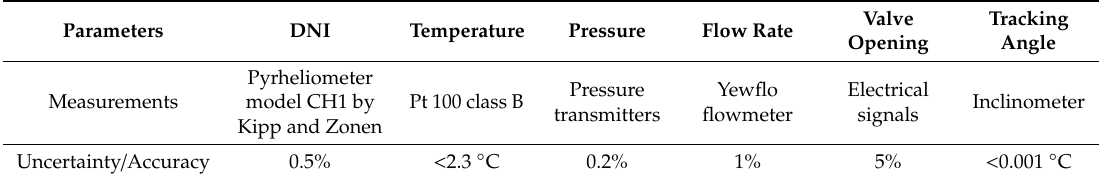
Table 2. Information about the measurements. DNI: direct normal irradiance.